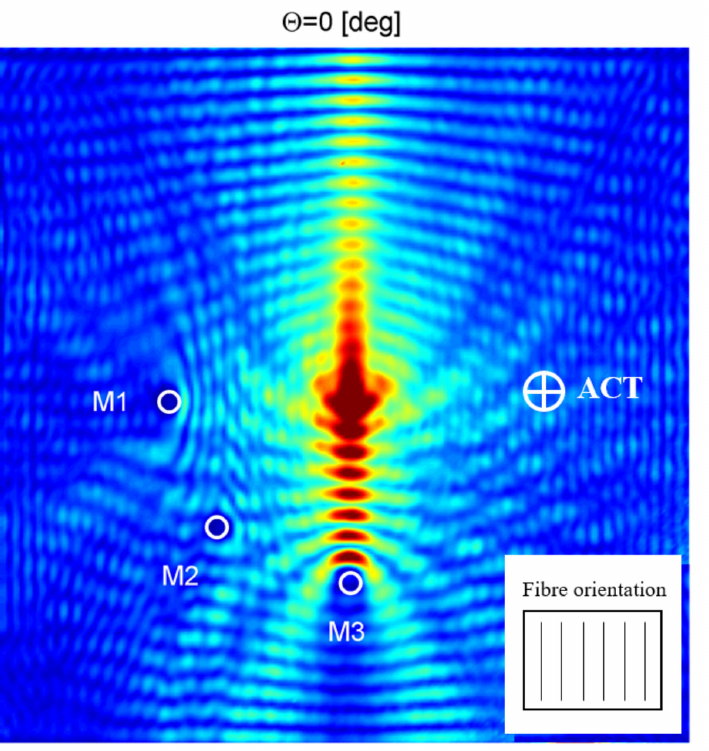
Figure 15. RMS energy map for the plate with discontinuities; ACT oriented at θ = 0 ◦ (perpendicular to the